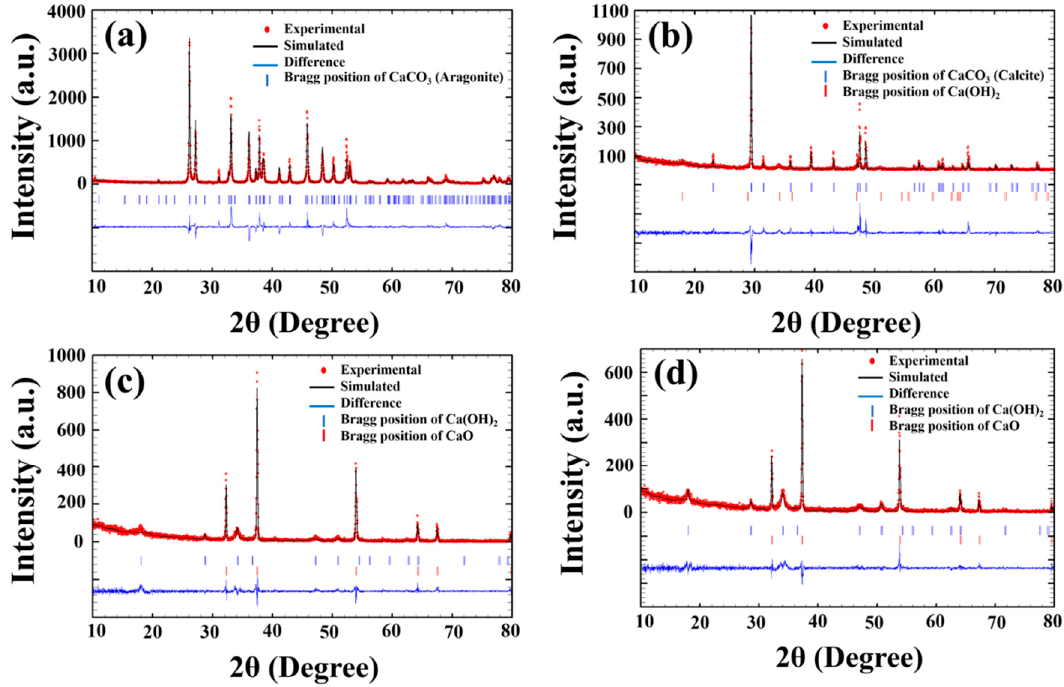
Figure 4. Fitted XRD patterns of the CS: ( a ) uncalcined and calcined CS powder at ( b ) 700 °C, ( c ) 900 °C and ( d ) 950 °C by the Rietveld refinement technique.